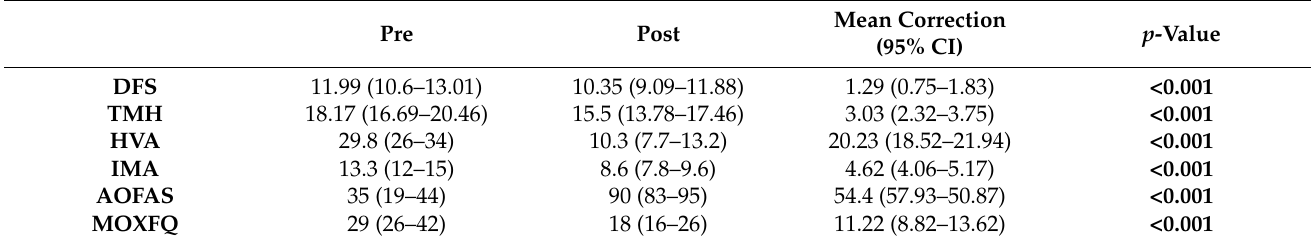
Table 1. Preoperative and postoperative values of quantitative variables ( n = 73). Pre: Preoperative values. Post: Values at follow-up. DFS: Distance of the fibular sesamoid bone to the second metatarsal axis. TMH: Translation of the first distal metatarsal head. HVA: Hallux valgus angle. IMA: I– II intermetatarsal angle. AOFAS: American Orthopaedic Foot and Ankle Society Questionnaire.